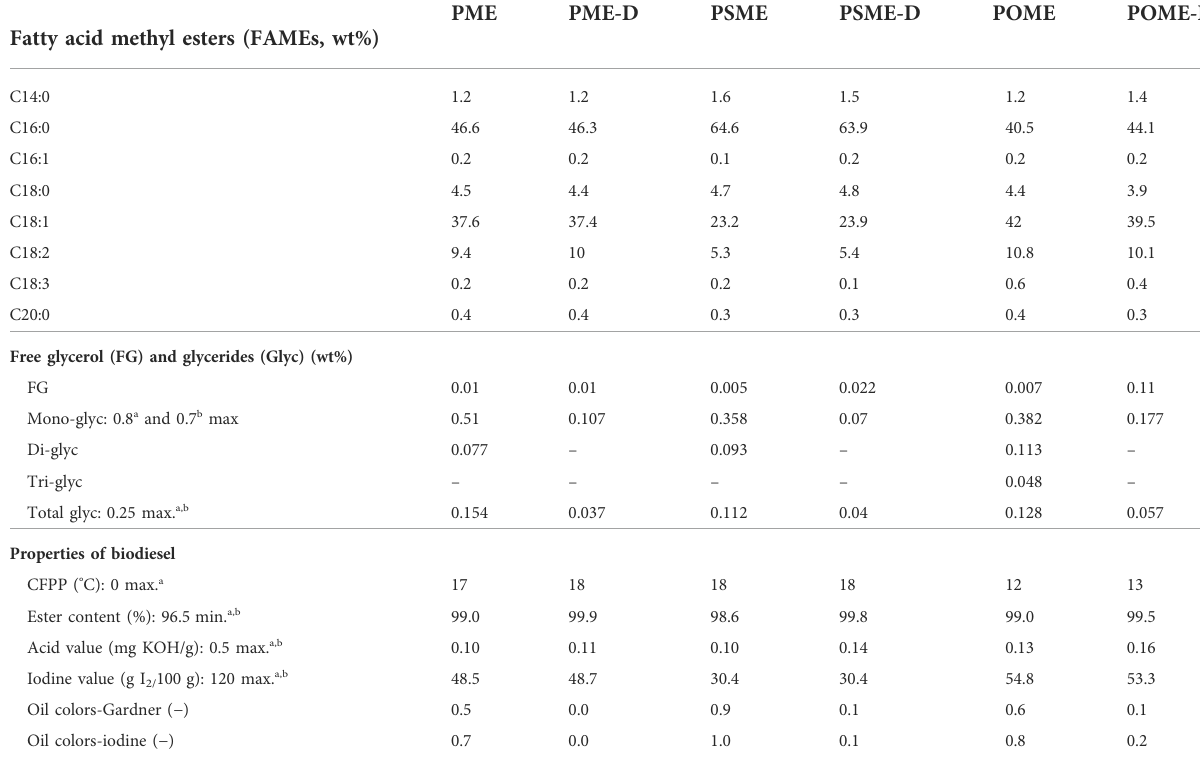
TABLE 1 Compositions, colors, and other properties of distilled and non-distilled palm